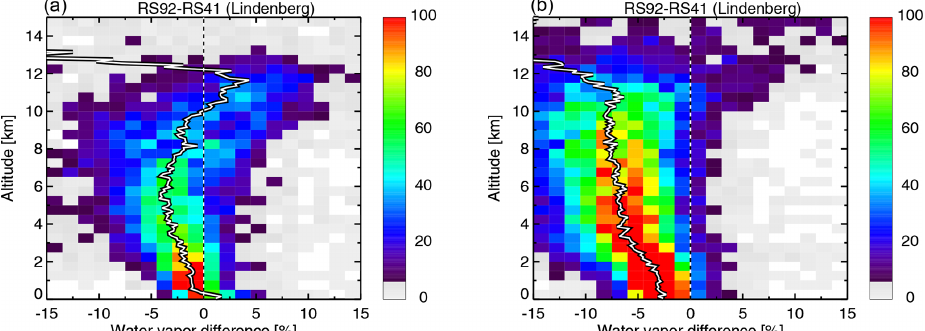
Figure 11. Same as Fig. 10 but for relative humidity. Shown is the relative difference 100 × (RH RS92-GDP.2 -RH RS41 ) / RH RS92-GDP.2 . The bin size for the scatter density plot is 0.5km × 2.5%RH. The average tropopause height over Lindenberg is approximately